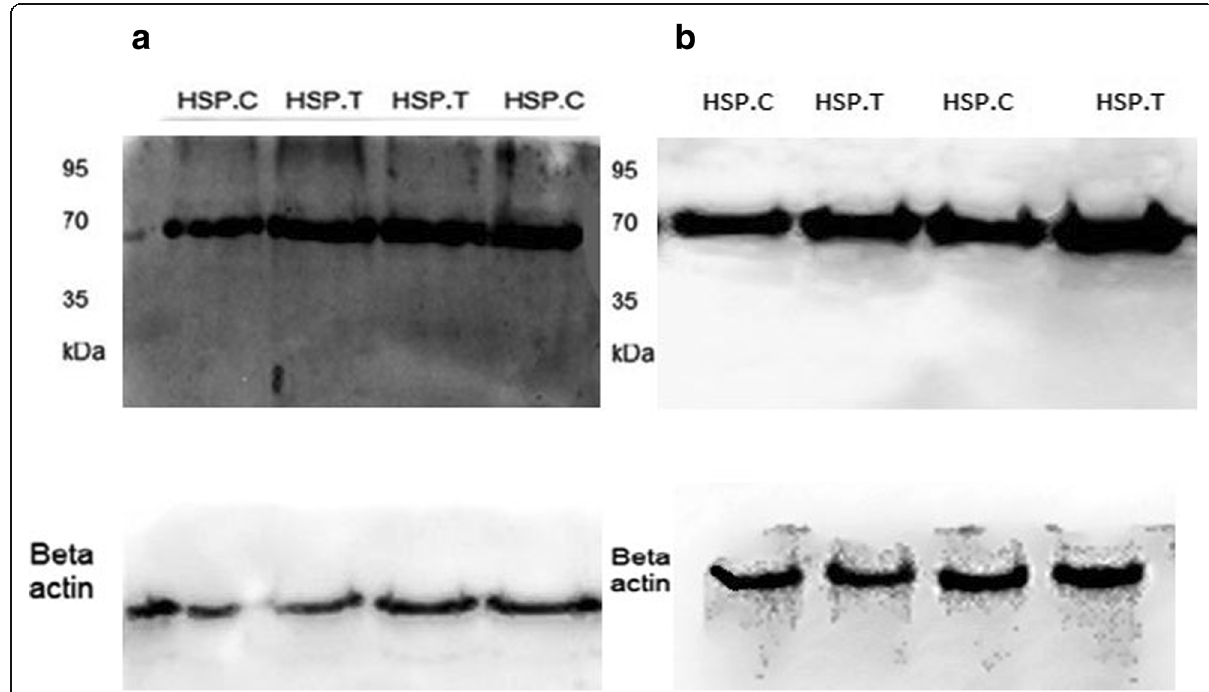
Fig. 1 Western blotting analysis of HSP70 level in normal ( a ) and asthenozoospermic ( b ) samples. (T) Treatment group with Vit.D3 and (C) control group without Vit.D3 and beta-actin was used as internal control